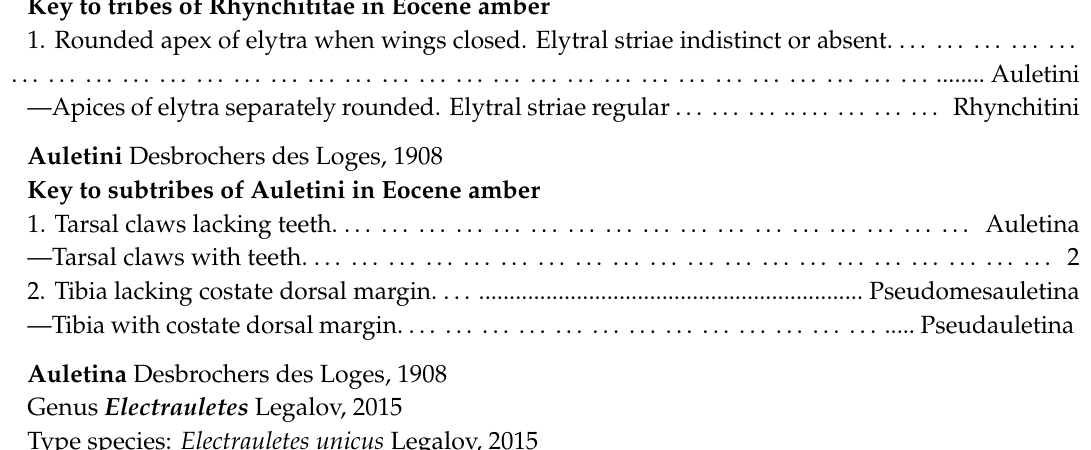
1. Rounded apex of elytra when wings closed. Elytral striae indistinct or absent.…Auletini